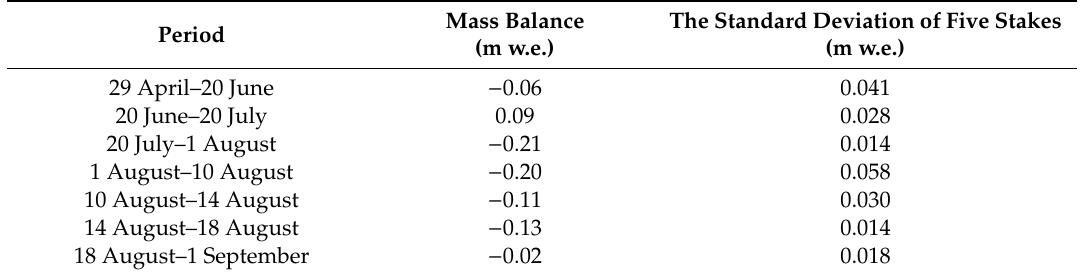
Table 4. The standard deviation of the mass balance measurement at the five stakes over the seven observation periods in 2018.